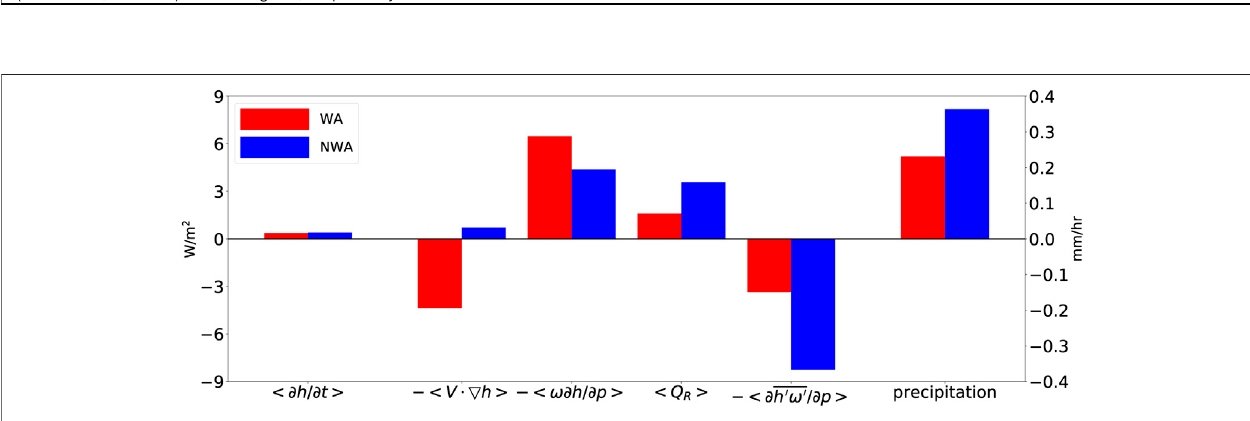
(YADV) components of the horizontal MSE advection. Over